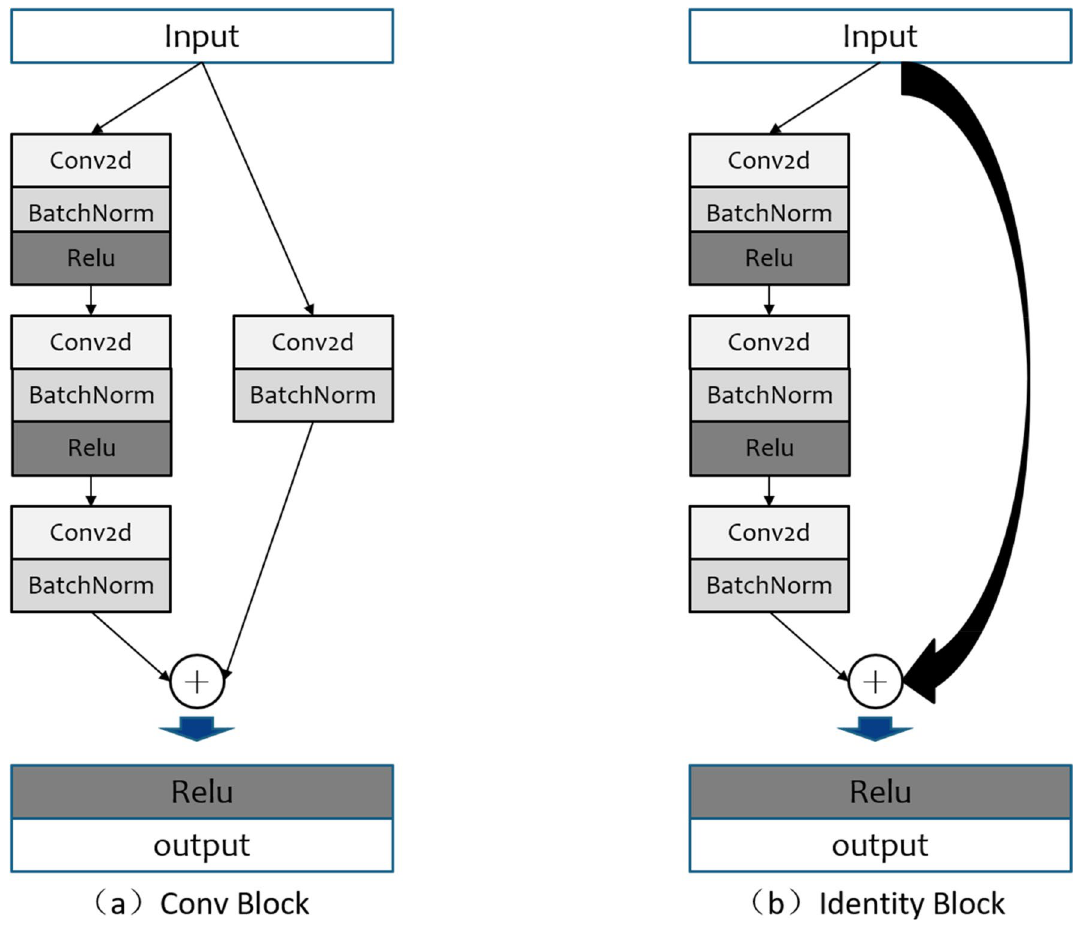
Figure 5. Two residual blocks in